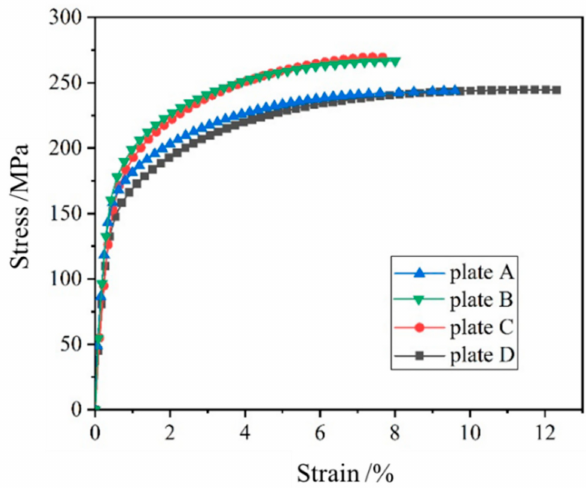
Figure 5. Engineering stress-strain curves of the tensile specimens of plates A, B, C, and